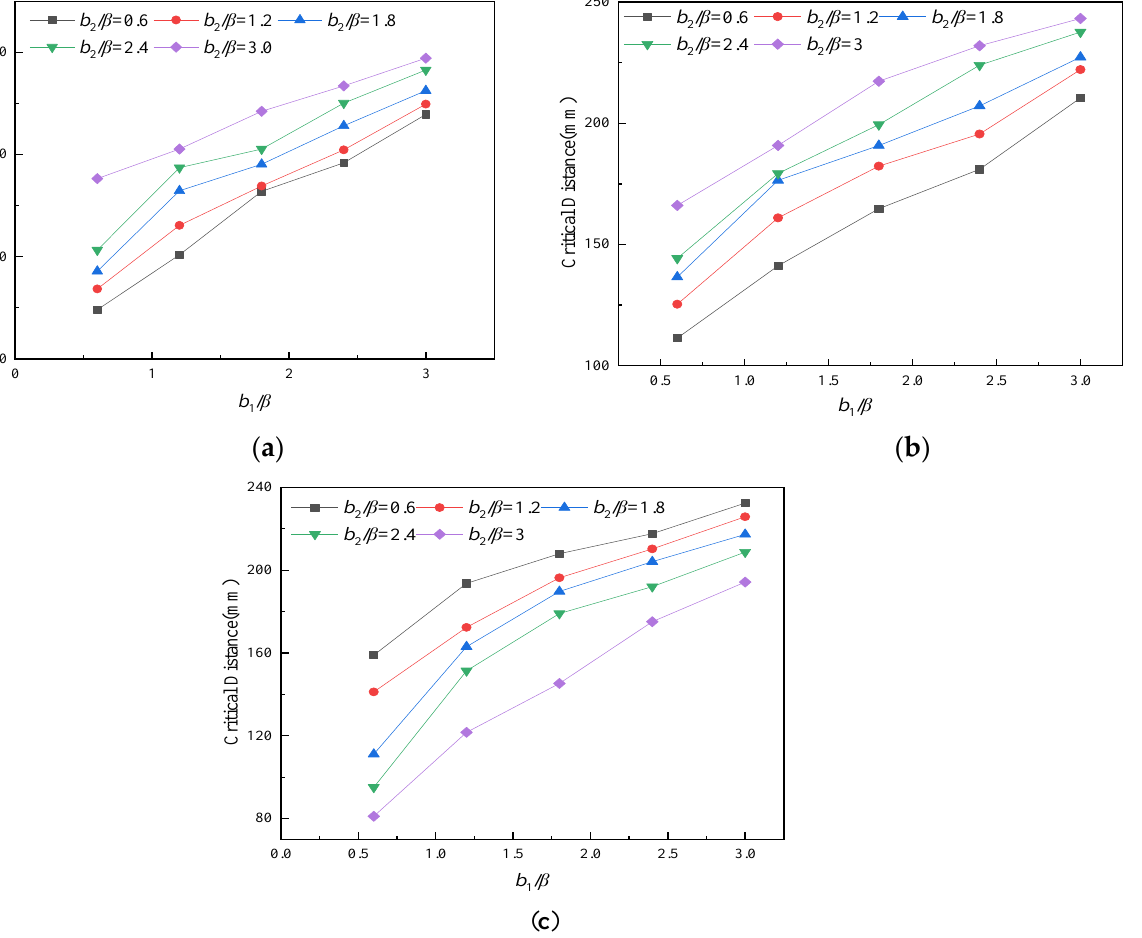
Figure 6. Diagram of impact of defect length on the critical distance: ( a ) the exterior wall; ( b ) the interior wall; ( c ) the interior and exterior wall.